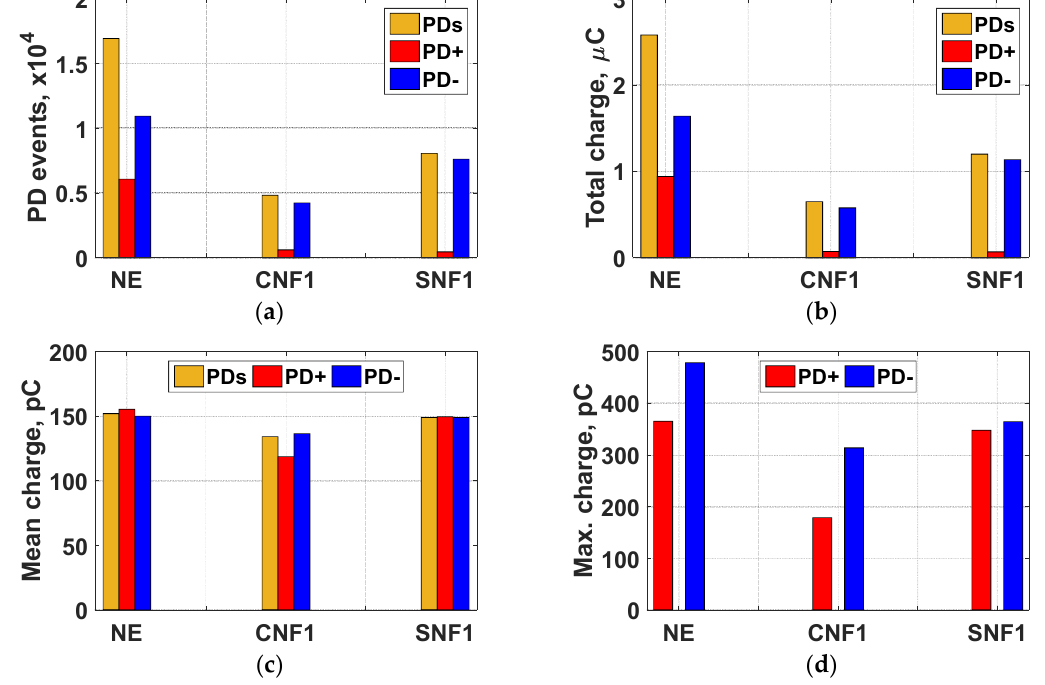
Figure 5. PD measurement results at 26 kVrms in 1500 cycles; ( a ) PD events, ( b ) total charge, ( c ) mean charge, and ( d ) maximum charge magnitude.